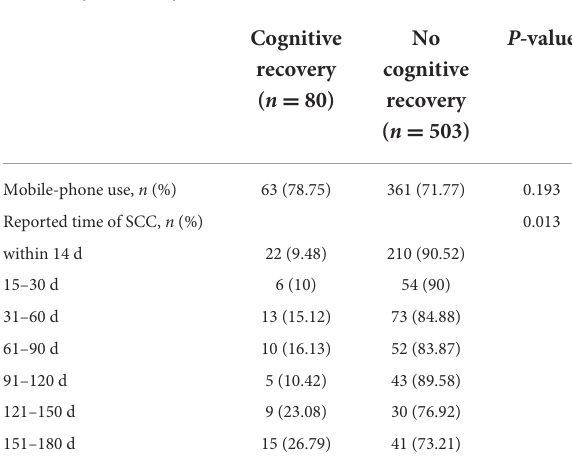
TABLE 2 Characteristics of patients with cognitive recovery vs. cognitive